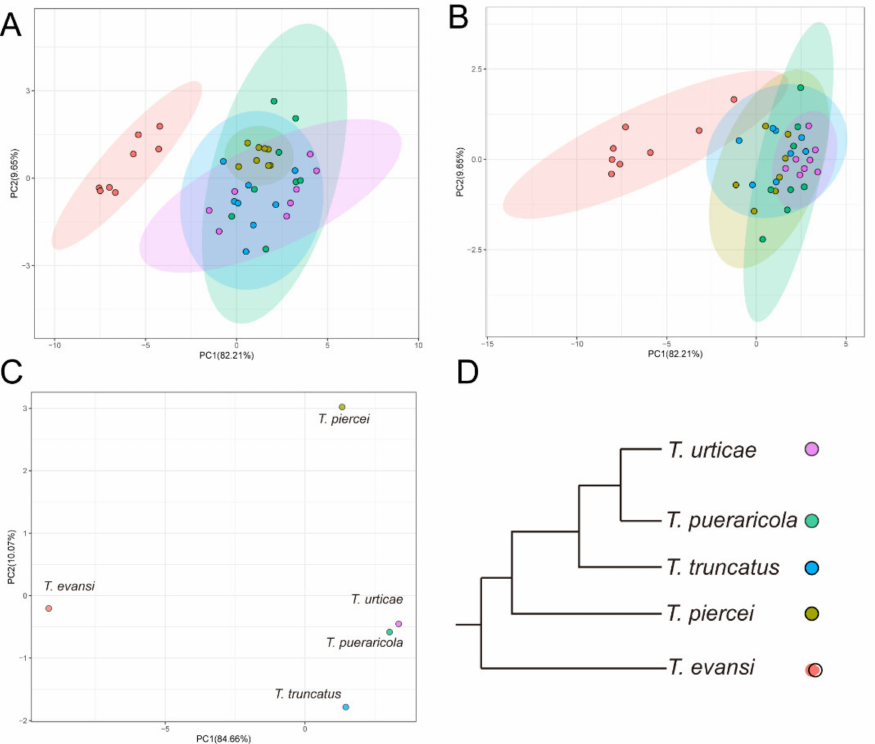
Figure 4. PCA results of host selection of spider mites. ( A ) PCA of leaf disc selection of bean and tomato by spider mites. ( B ) PCA of leaf disc selection of bean and eggplant by spider mites. ( C ) PCA of leaf disc selection and Y-tube olfactory selection. ( D ) Relative positions of five species of spider mites in phylogenetic trees inferred by DNA sequences. The tree was depicted according to the previous phylogenetic studies using 18S and 28S rRNA genes, mitochondrial cytochrome c oxidase subunit 1 gene [17], RNA-Seq data [18] and mitochondrial genome [19] with a maximum likelihood